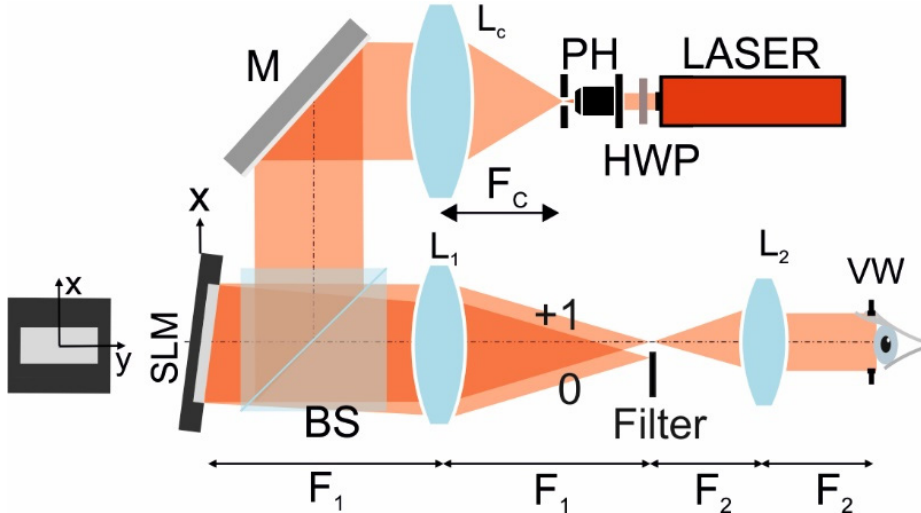
Figure 8. Wide-angle near-eye holographic display setup.